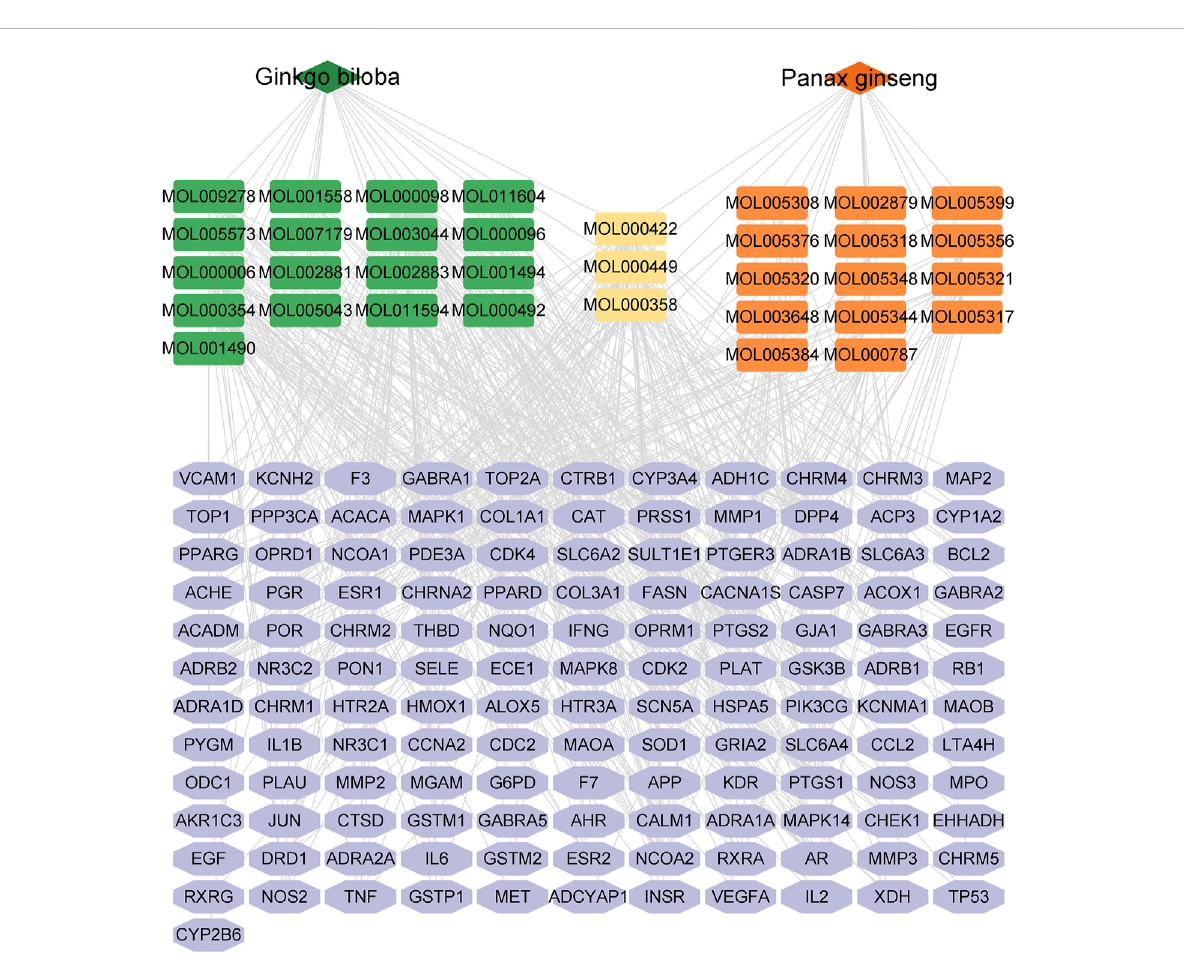
TABLE 2 The main chemical compositions and targets of